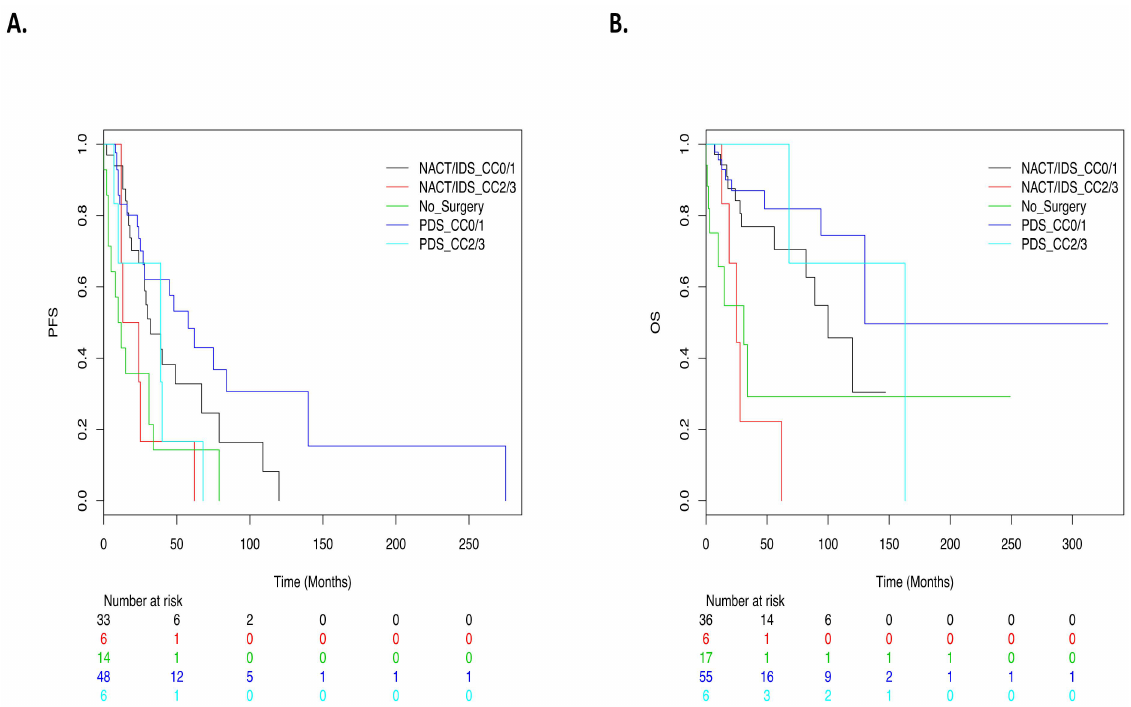
Figure 2. Survival curves. ( A ) Progression-free survival according to time of debulking surgery and Completeness of Cancer Resection (CCR) score. ( B ): Overall survival according to time of debulking surgery and Completeness of Cancer Resection (CCR) score. Five groups: no surgery in green, primary debulking surgery with optimal or incomplete resection (PDS-CC0 or CC1 in dark blue, PDS-CC2 or CC3 in light blue), interval debulking surgery with optimal or incomplete resection (NACT/IDS-CC0 or CC1 in dark blue, NACT/IDS-CC2 or CC3 in red). Estrogen receptor expression was an indicator of good prognosis in the overall population (HR = 0.41, IC95% (0.17–0.89), p = 0.02) and particularly for patients with PDS (HR = 0.04, IC95% (0.001–0.63), p = 0.001). A positive peritoneal cytology ( p = 0.67), metastatic pelvic or para-aortic nodes ( p = 0.06), perioperative complications ( p = 0.99), early postoperative complications ( p = 0.36), late postoperative complications ( p = 0.71), progesterone receptor expression ( p = 0.43), adjuvant chemotherapy ( p = 0.45), use of bevacizumab ( p = 0.93) and use of hormonal therapy ( p = 0.12) had no impact on PFS (Table